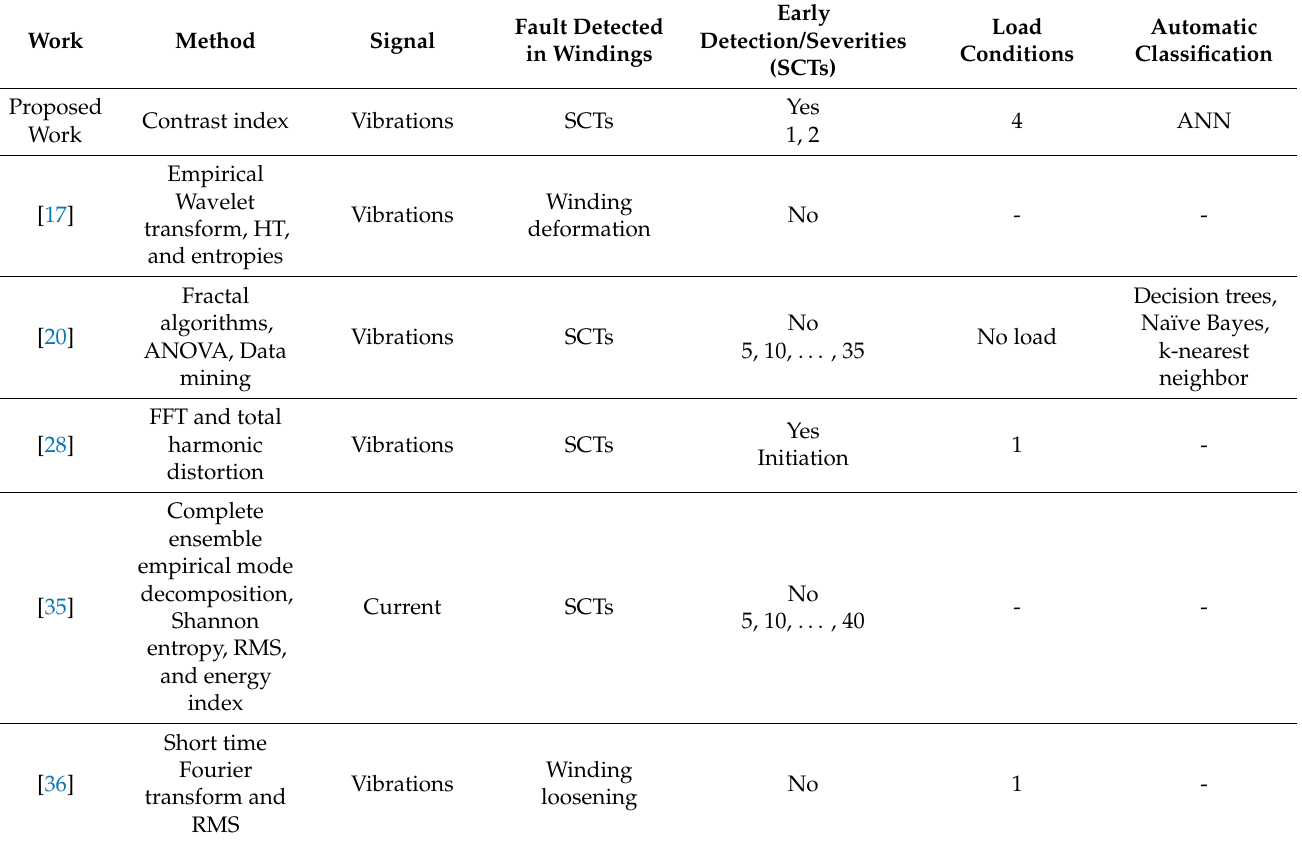
Table 5. Comparison of the proposed work and other